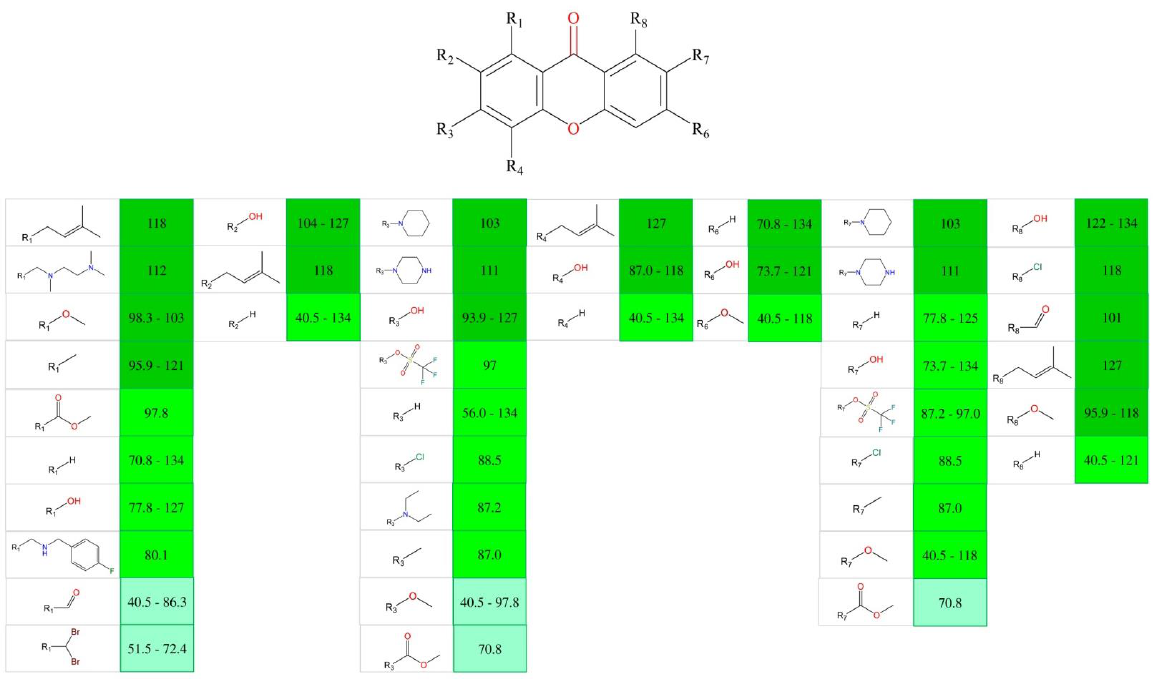
Figure 4. Analysis of activity according to substitutions. Viability at 10 µM after 48 h is represented with a gradient background (darker: higher viability; lighter: lower viability).